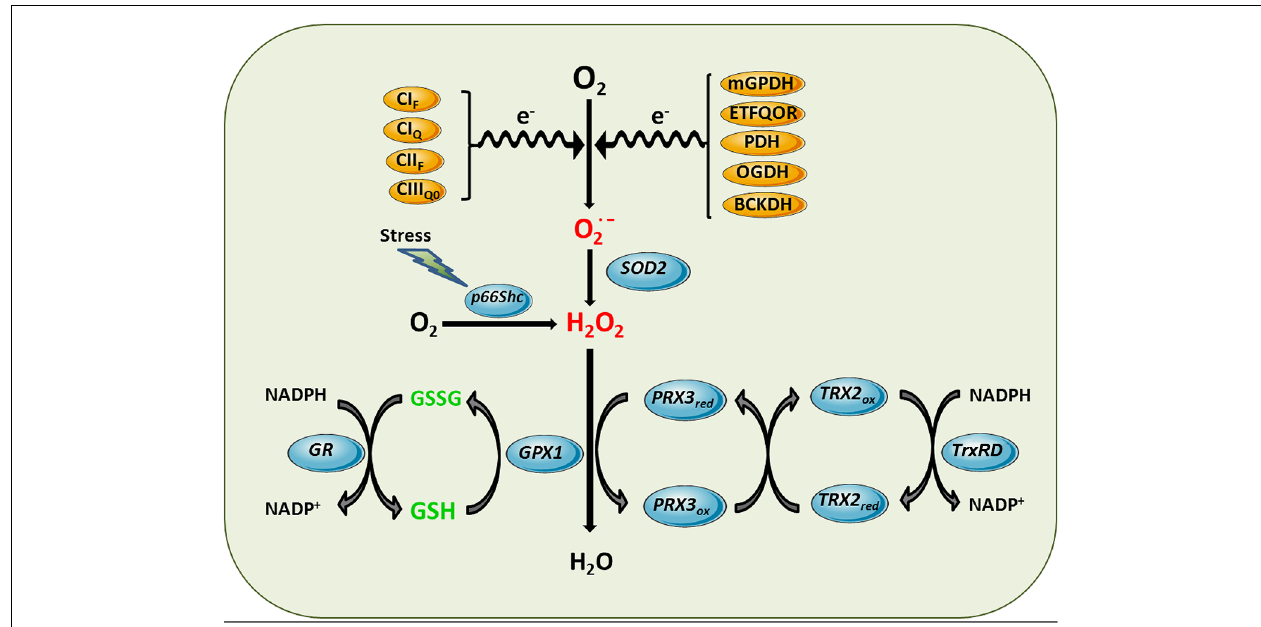
FIGURE 2 | Mitochondrial ROS generation and antioxidant defense systems. Complex I flavin site (CI F ), Complex I ubiquinone site (CI Q ), Complex II flavin site (CII F ), and Complex III Qo (CIII Q 0 ) are sites of the ETC components shown to generate superoxide anion. Other sources